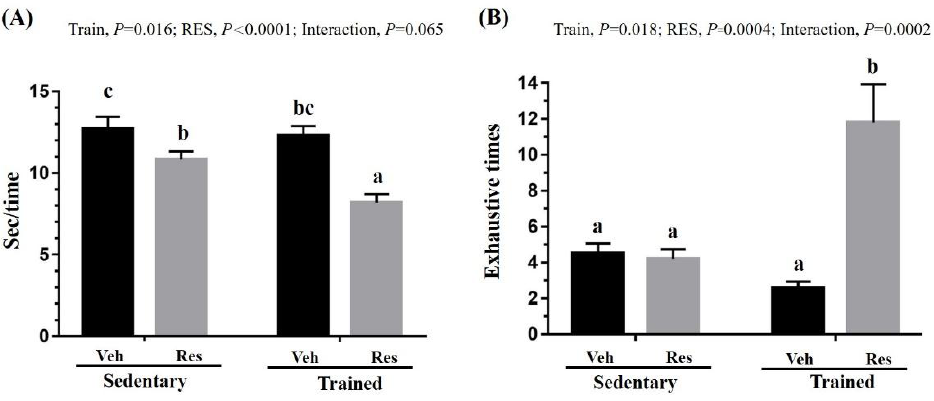
Figure 4. Effect of climb training (Trained) and/or resveratrol (RES) supplementation on anaerobic endurance performance, including time for each climbing ( A ) and exhaustion times for climbing ( B ). Data are mean ± SEM for n = 10 mice per group and the columns with different superscript letters (a, b, c) are significantly different at P < 0.05. The abbreviations Veh and RES represented the vehicle and resveratrol supplement, respectively.